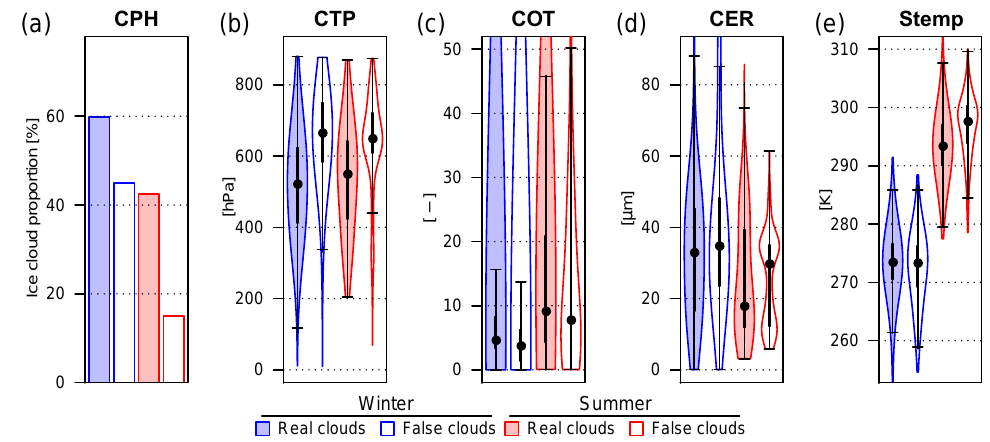
Figure 5. Distributions of values of five cloud properties (phase (CPH), top pressure (CTP), optical thickness (COT), effective radius (CER), surface temperature (stemp)) retrieved from MODIS-Aqua in winter and summer at nine stations located above 1000m of altitude, for actual clouds and falsely detected ones (using SYNOP observations as a